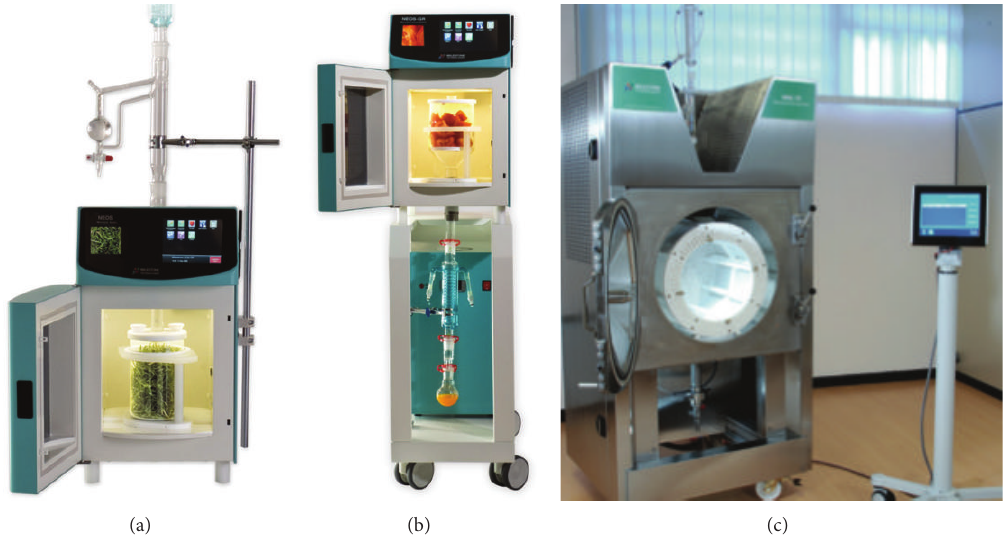
Figure 5: Neos, Neos-GR, and MAC-75 (Milestone